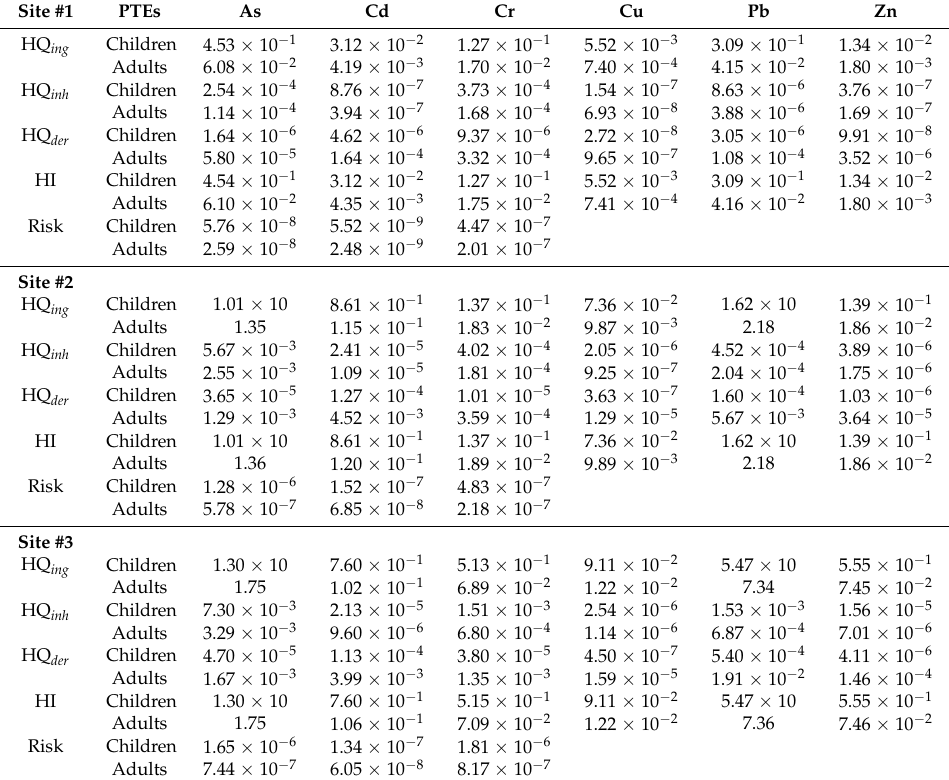
Table 5. Health risks of PTEs in soils on rural abandoned metallurgy lands in north China. HQ = hazard quotient; HI = hazard